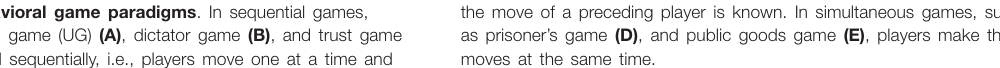
the move of a preceding player is known. In simultaneous games, such as prisoner’s game (D) , and public goods game (E) , players make their moves at the same